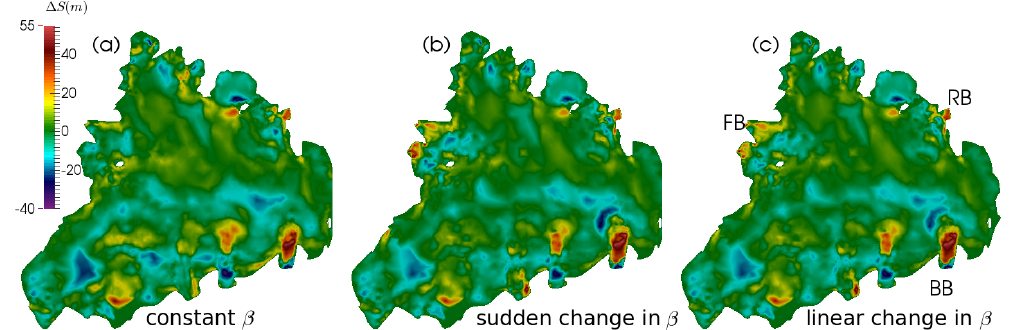
Figure 10. Change in surface elevation, 1S( m ) , during the prognostic 1995–2008 simulations for the three scenarios: (a) constant basal friction parameter, simulation const13 , (b) sudden jump after 5 years, simulation sudden13 and (c) linear change in basal friction parameter, simulation lin13